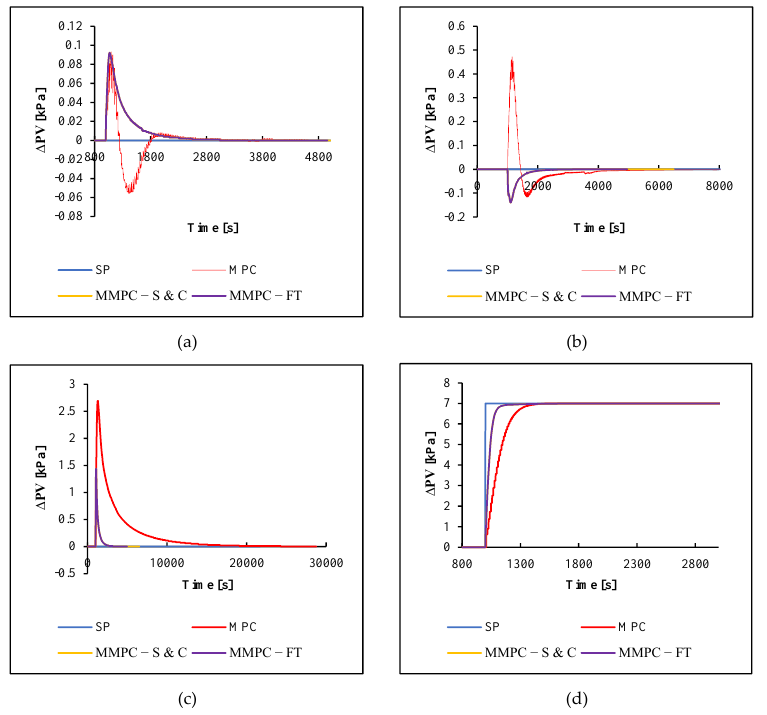
Figure 10. Comparison of controller performance with SP changes on compressor unit 4 (MIMO Model 2) on: ( a ) compressor unit 1; ( b ) compressor unit 2; ( c ) compressor unit 3; and ( d ) compressor unit 4. Table 11. Comparison of IAE and ISE on the compressor unit with changes on compressor unit 1 (MIMO Model 2). CV Error